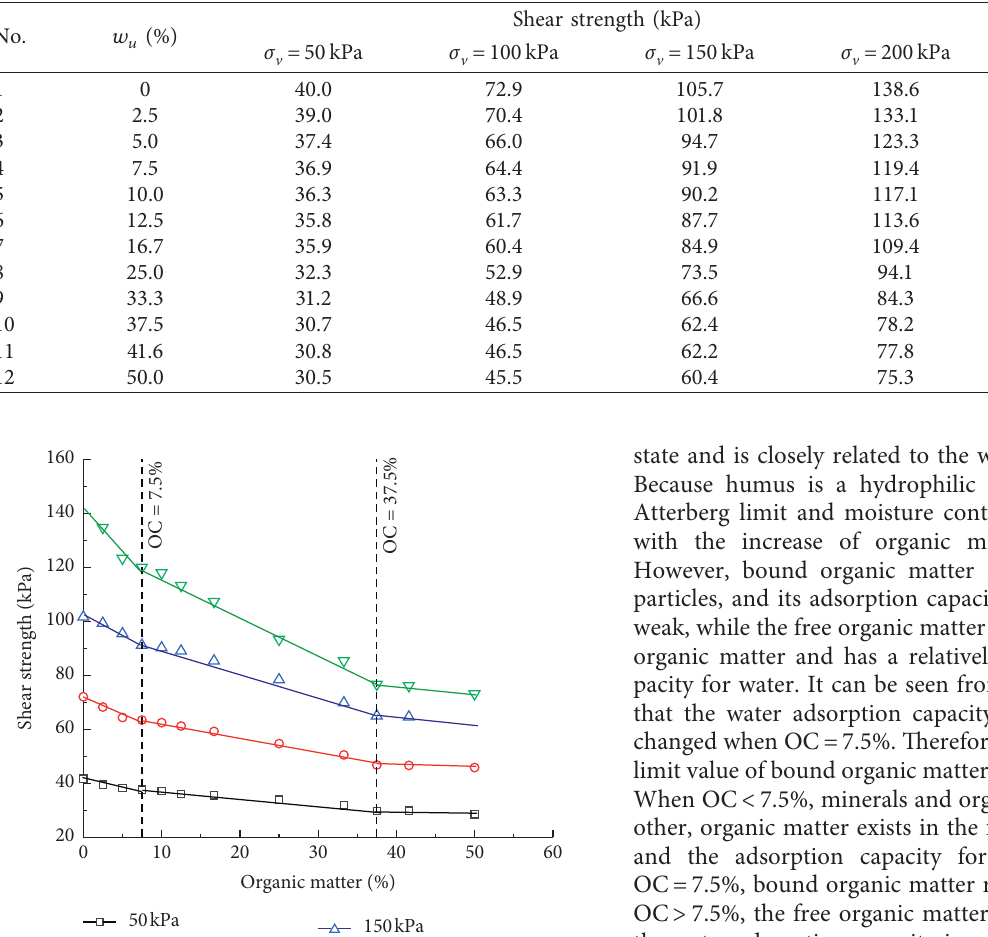
Table 5: Shear properties of samples.